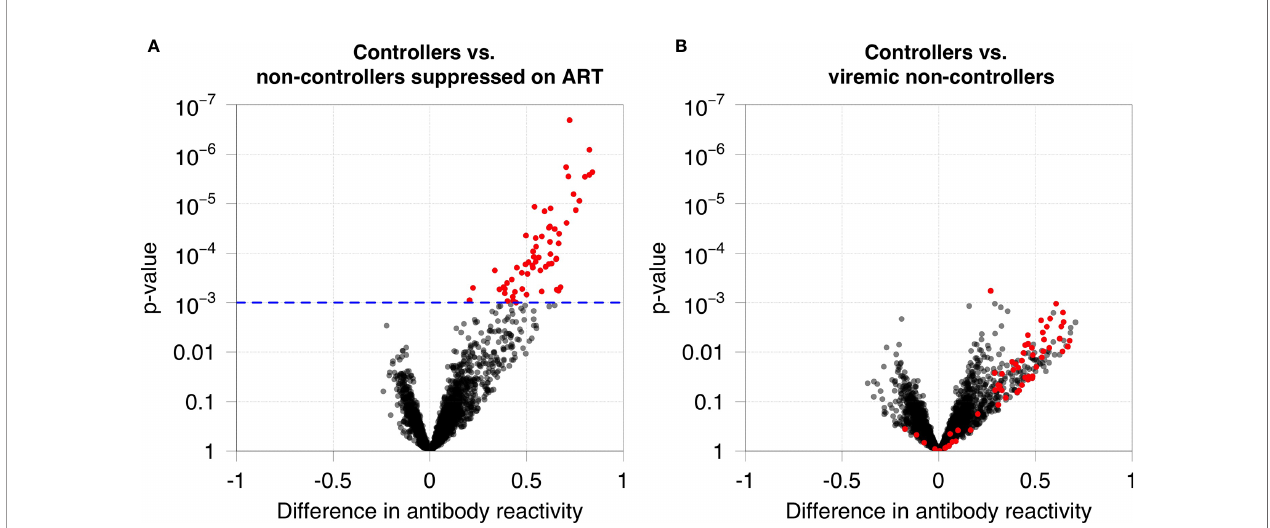
FIGURE 1 | Antibody reactivities in HIV controllers compared to non-controllers. (A) Antibody reactivity was compared for 40 HIV controllers (13 elite controllers and 27 viremic controllers) and 21 non-controllers suppressed on ART. The volcano plot shows on the x-axis the difference in antibody reactivity in the two groups (estimated log 10 fold change; positive numbers correspond to stronger reactivity in controllers) and the y-axis shows the -log 10 p-value for each peptide based on moderated t-statistics. Red dots indicate the 62 peptides that are signi fi cantly more reactive in controllers at a false discovery rate of 5%. The blue dashed line indicates the highest q-value less than 5% (q=0.0485), which corresponds to a p-value of 0.001. (B) Antibody reactivity to each HIV peptide was compared for 40 HIV controllers and 12 viremic non-controllers. No signi fi cant differences in antibody reactivity were observed for these 62 peptides in these two